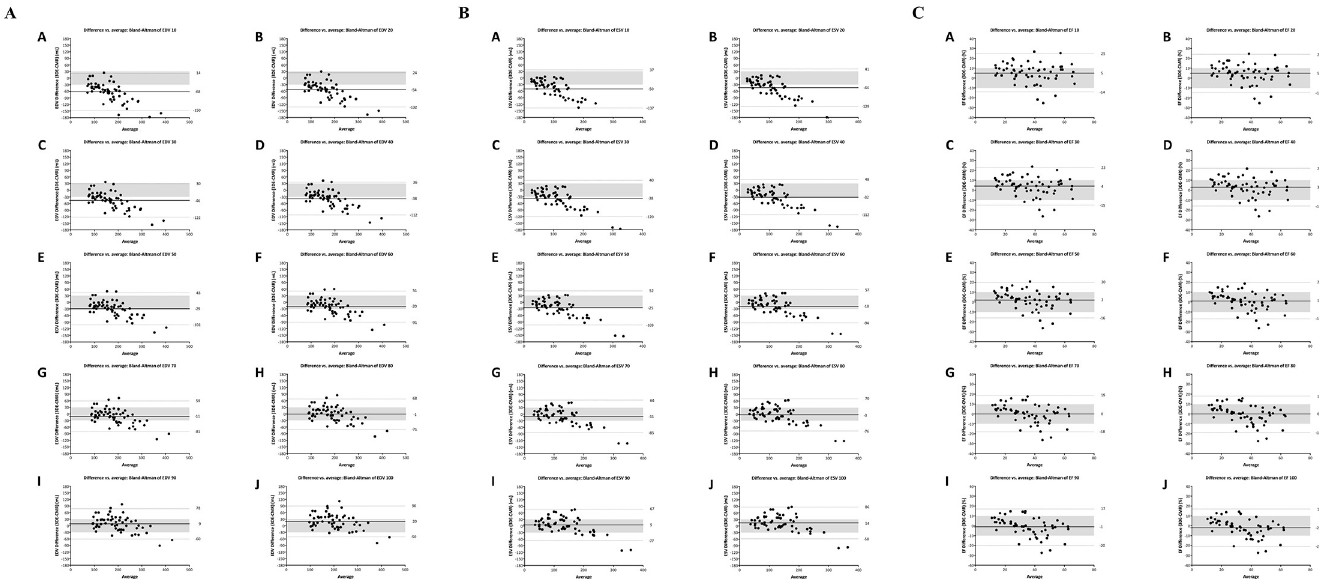
Fig 3. Bland-Altman analysis of left ventricular end-diastolic volume (Fig 3A), left ventricular end-systolic volume (Fig 3B), and left ventricular ejection fraction (Fig 3C) between cardiac magnetic resonance disk-summation method and 3D echocardiography with automated quantification software (Dynamic HeartModel) according to change in border setting from 10 to 100. A, border threshold of 10; B, border threshold of 20; C, border threshold of 30; D, border threshold of 40; E, border threshold of 50; F, border threshold of 60; G, border threshold of 70; H, border threshold of 80: I, border threshold of 90; J, border threshold of